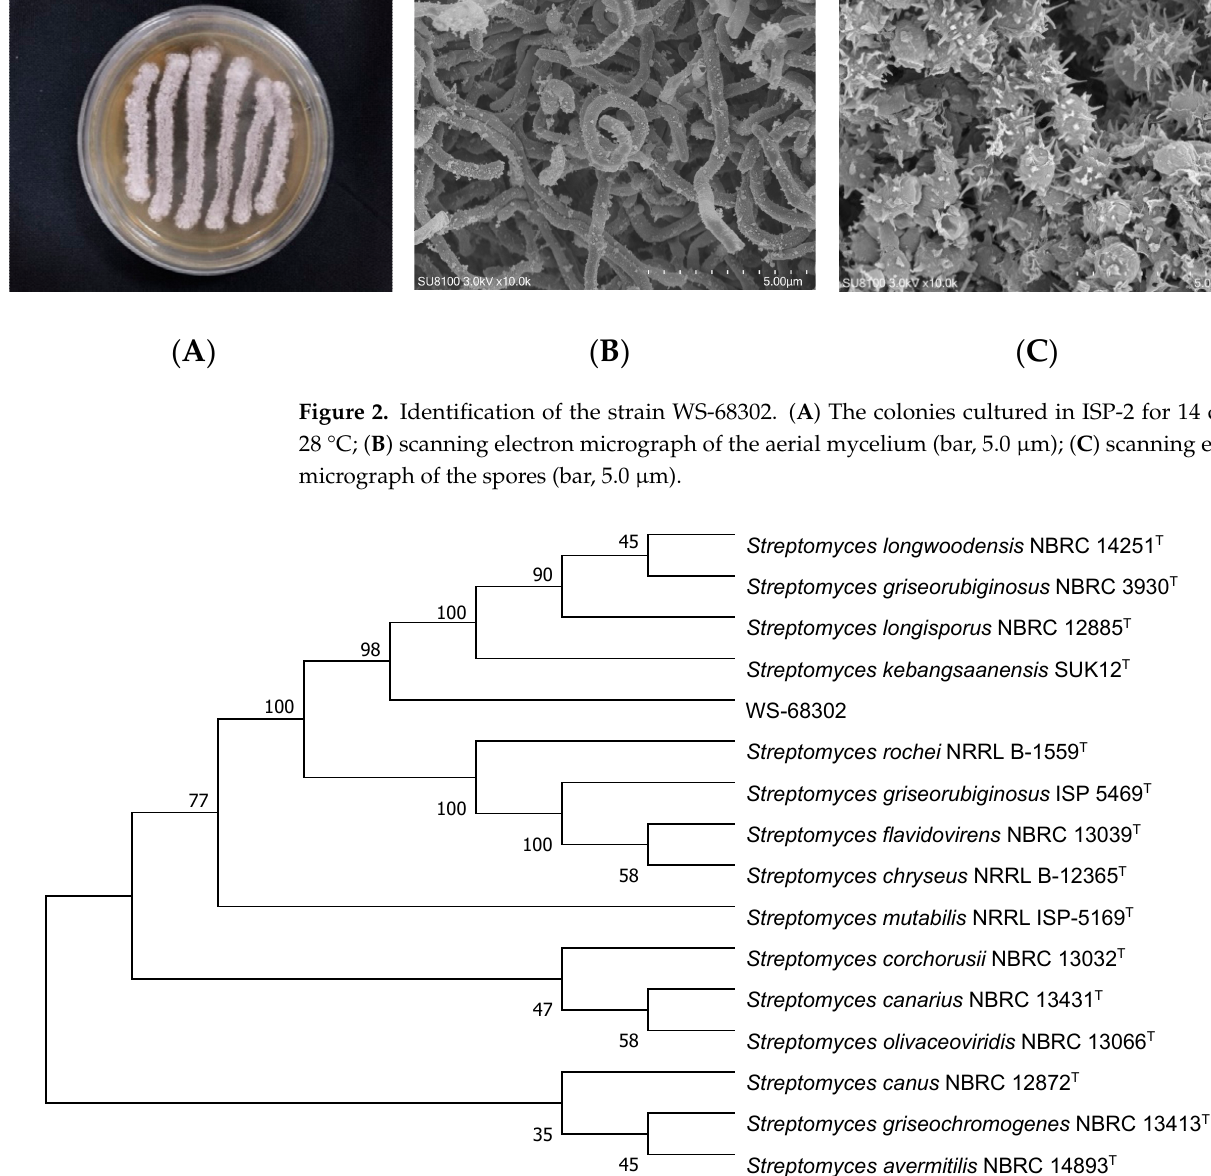
Figure 3. Phylogenetic tree based on 16S rRNA sequences of the S . kebangsaanensis WS-68302.